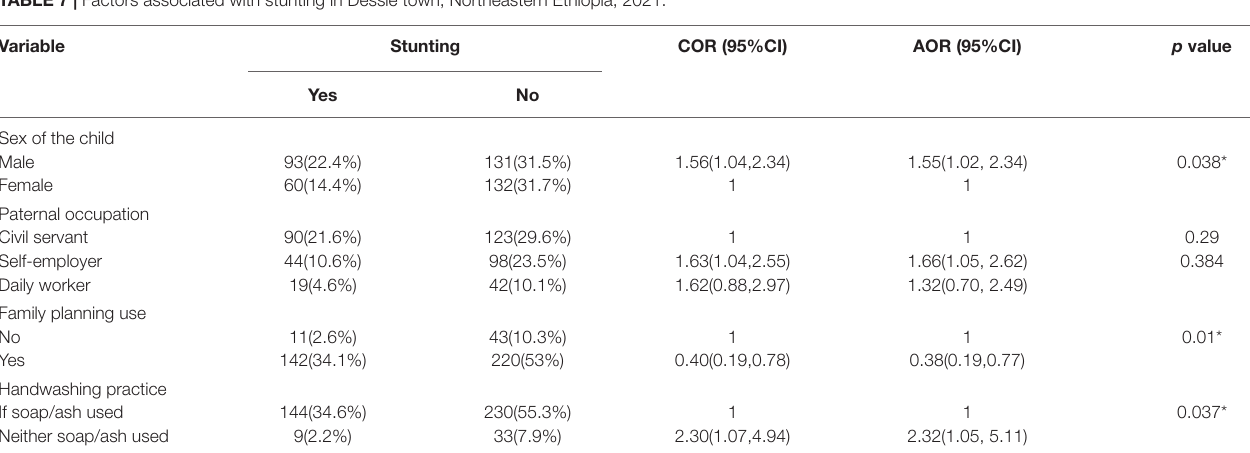
FIGURE 3 | Weight-for-height Z score among children aged 6–23 months in Dessie town, Northeastern Ethiopia, 2021. TABLE 7 | Factors associated with stunting in Dessie town, Northeastern Ethiopia,